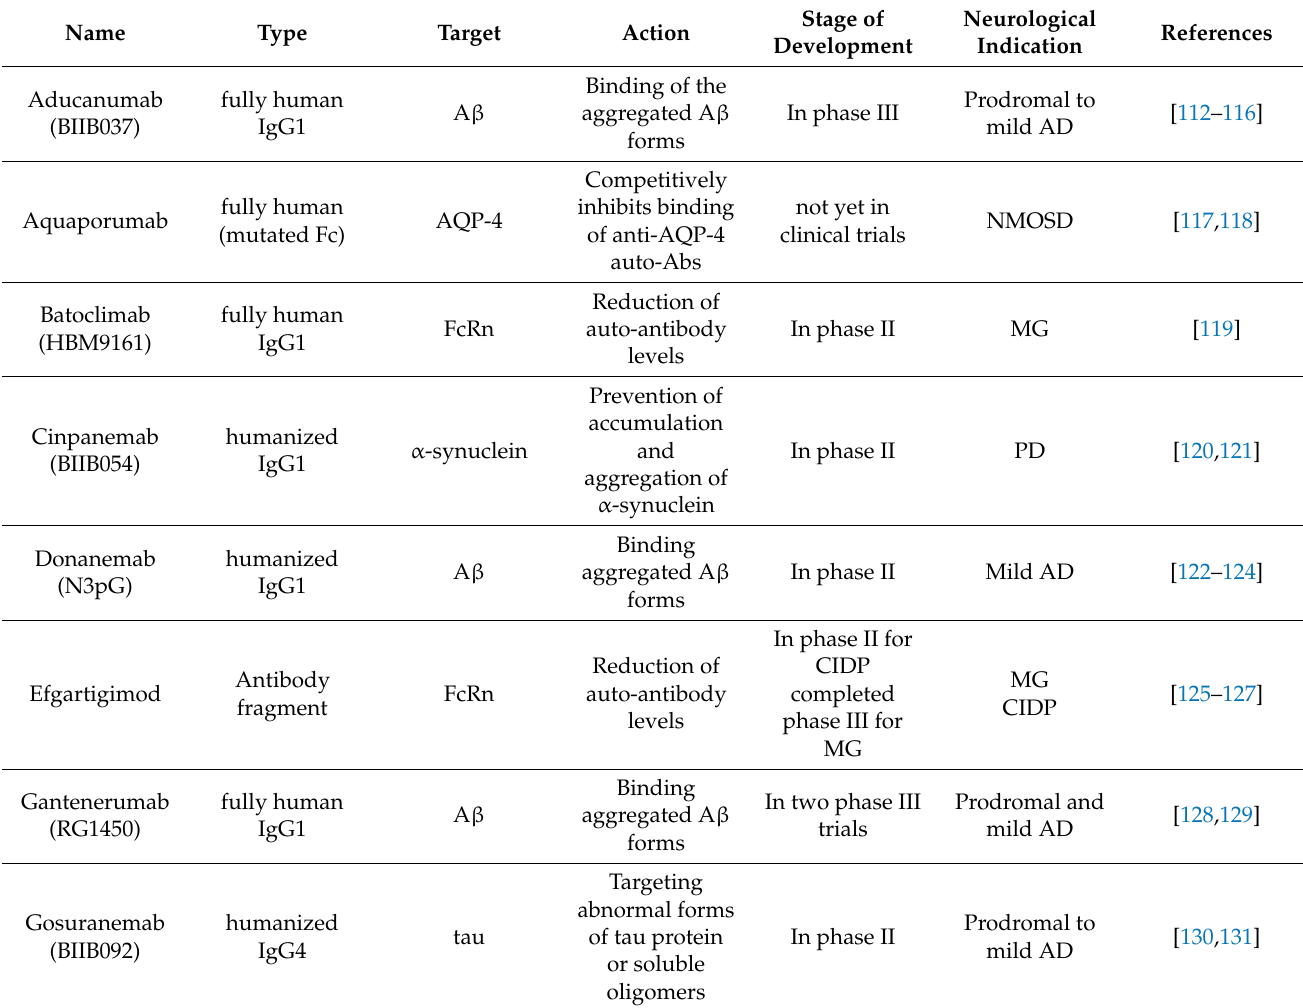
Table 2. Monoclonal antibodies in development for various neurological